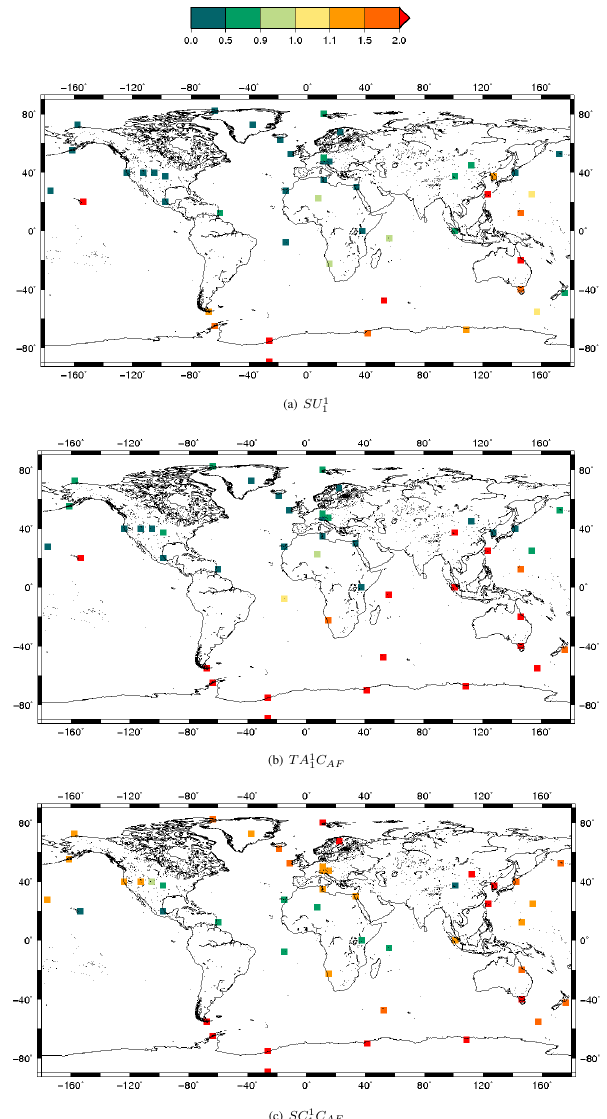
Fig. 8. Fit at surface sites (unitless) represented as the ratio of the posterior to the prior values of bias (in absolute values) between simulated and observed methane concentrations.